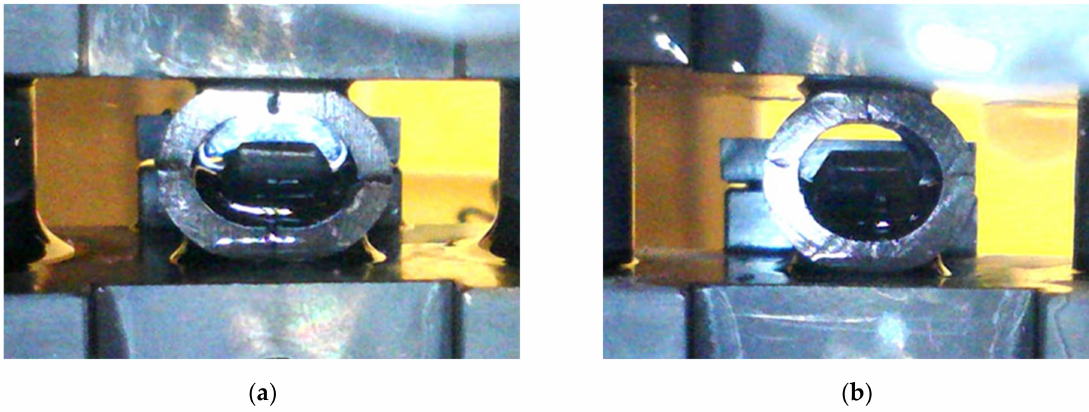
Figure 27. ( a ) 100 dpa specimen and ( b ) 65 dpa specimen after test in PWR water with 49 cc/kg H 2